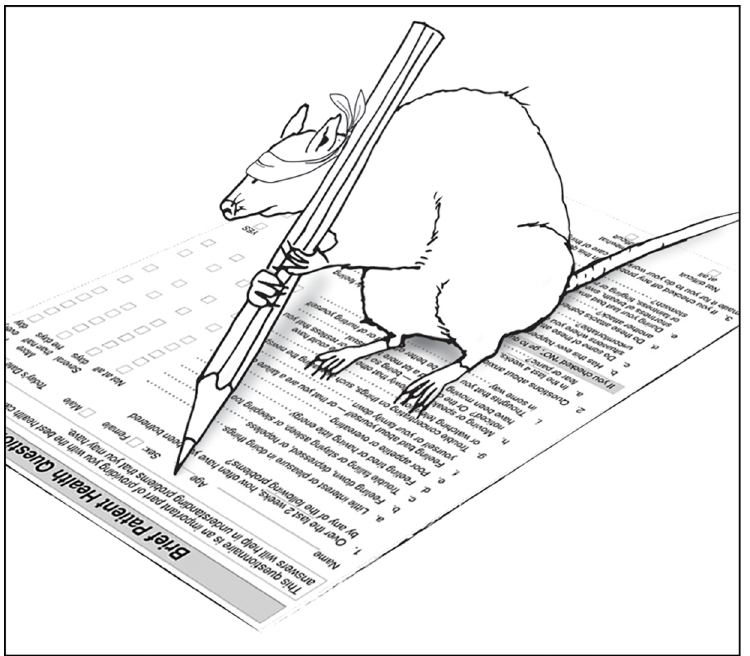
Fig 1. To avoid bias, the mouse was blinded when self-reporting outcomes. Image credit: Lorris Williams.